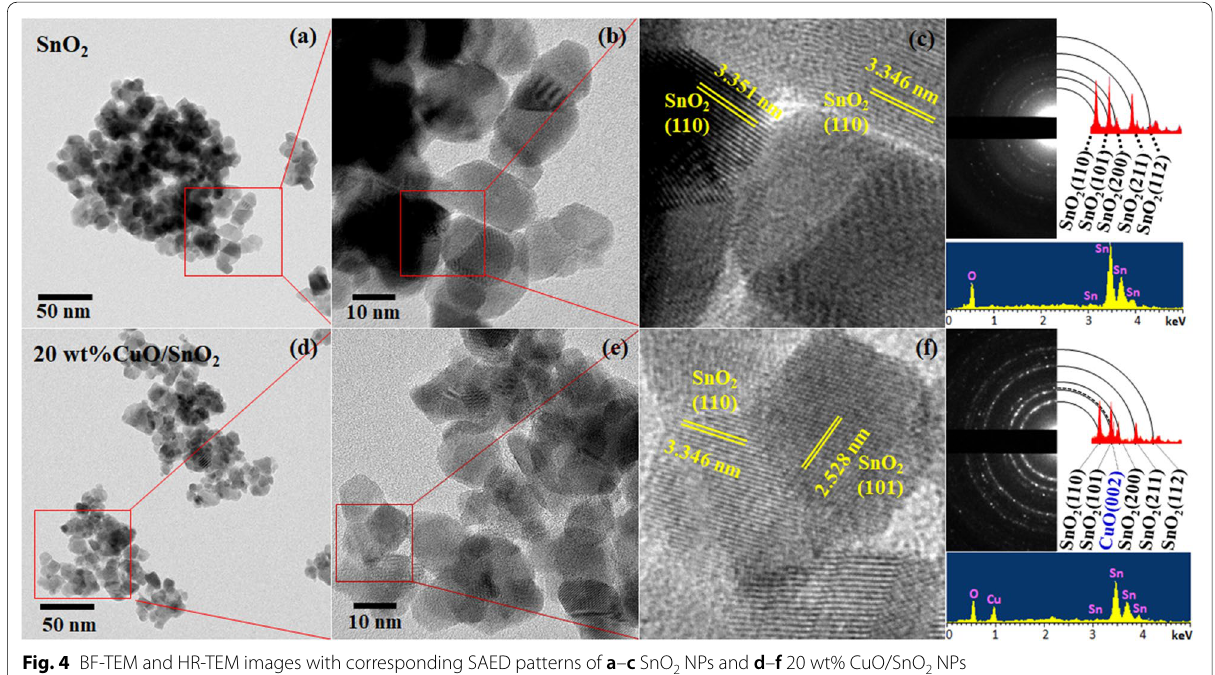
Fig. 4 BF-TEM and HR-TEM images with corresponding SAED patterns of a – c SnO 2 NPs and d – f 20 wt% CuO/SnO 2 NPs